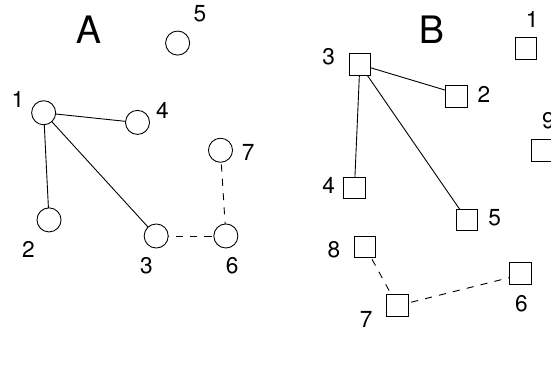
Figure 1. Schematic of situation after Step 1 of algorithm. The two sets A and B of atoms to be matched are shown as circles and squares, respectively. For clarity, all atoms are of the same type, and the minimum degree of the central node in each star is ν = 2 . We find two pairs of atoms from A and B with ν = 2 or more distance differences smaller than δ b atom pair a (solid lines) and atom pair a 1 3